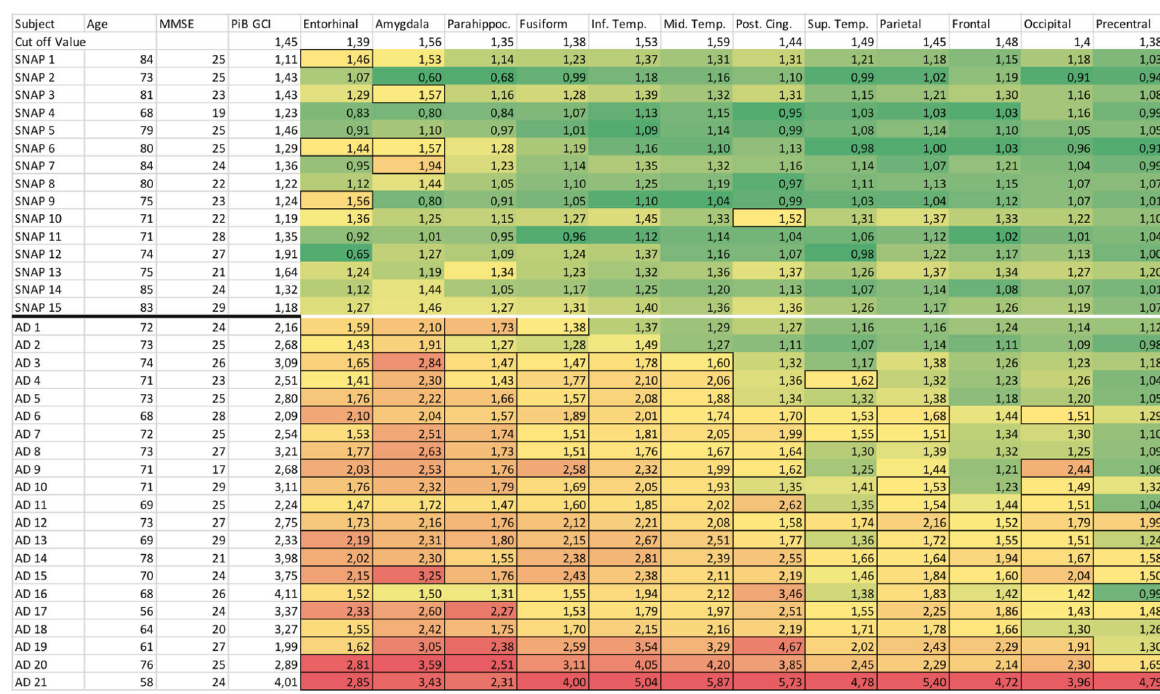
Fig. 1 Individual tau PET imaging SUVr (mean of the left and right sides) for each SNAP and AD patient in each VOI. Green boxes correspond to the lowest values and red boxes to the highest values. The boxes are framed when the SUVr is above the cut-off value de fi ned from our control group. MMSE, Mini-mental State Examination; GCI, global cortical index; Parahippoc, parahippocampal gyri; Inf. Temp., Inferior temporal gyri; Mid.Temp., Middle temporal gyri; Post. Cing., posterior cingulate; Sup. Temp., Superior temporal